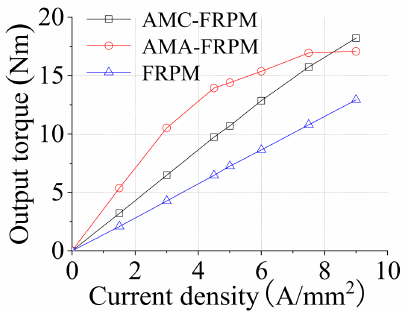
Figure 18. Output torques with different current densities for the three machines.